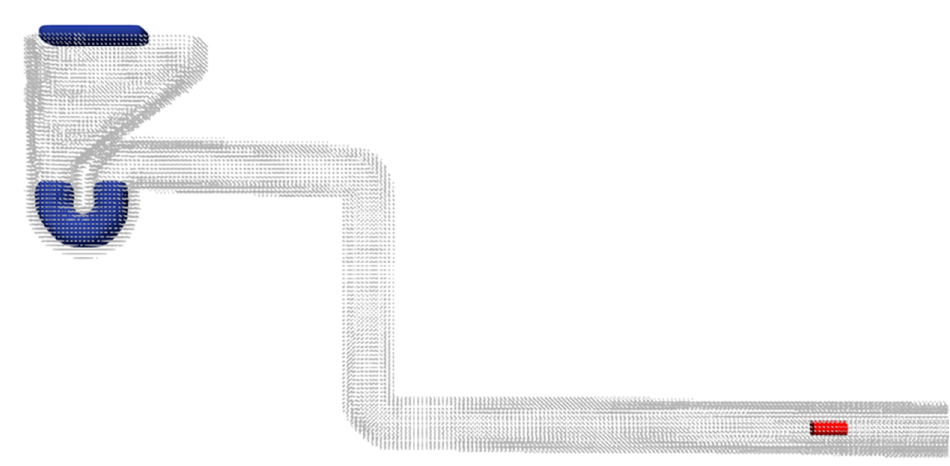
Figure 5. Smoothed particle hydrodynamics (SPH) geometry and the arrangement of the water inlet and solid positioning.